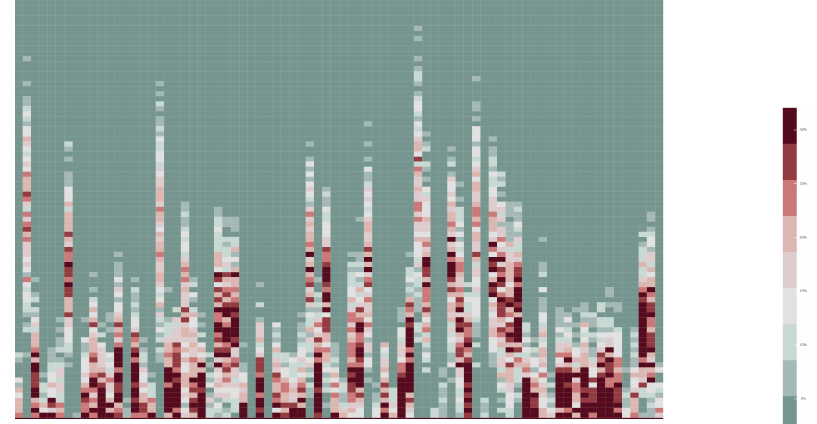
Figure 1. Activation distribution from different units of trained FC